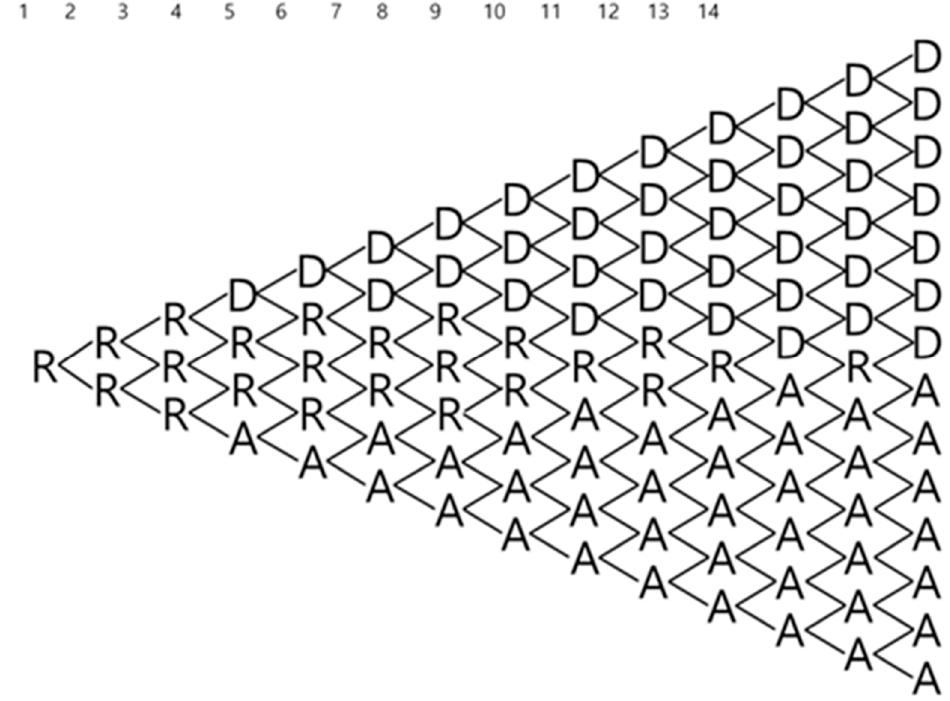
Figure 6. Two-dimensional optimal decision lattice considering fossil energy prices uncertainty (A: abandonment, D: deployment, R: R&D investment)3.3. Sensitivity analysis.